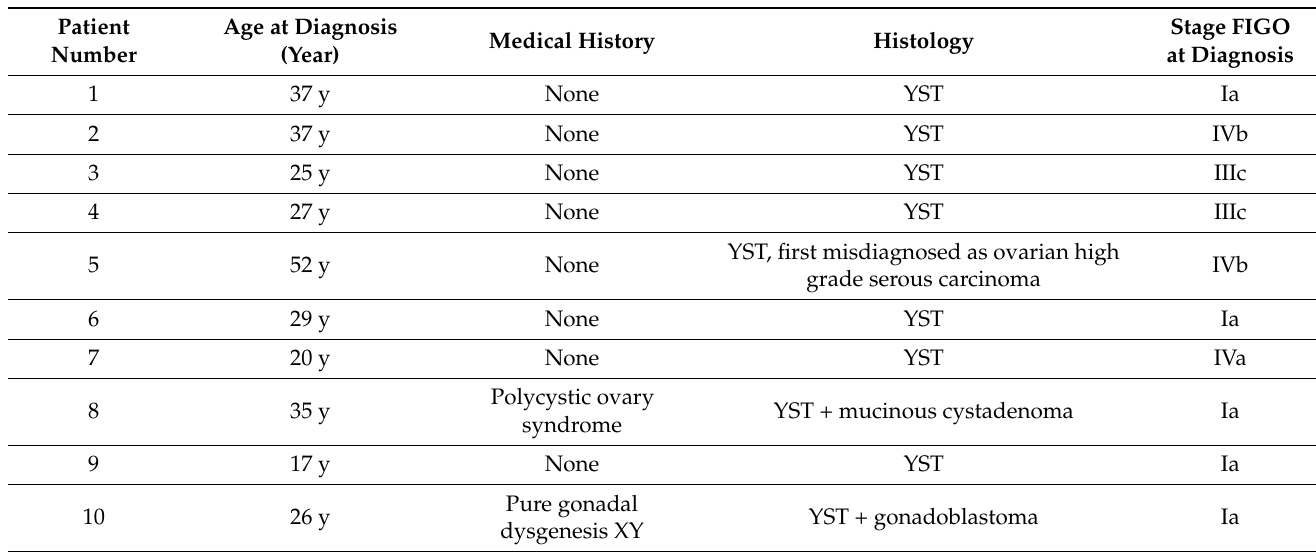
Table 1. Patient characteristics.